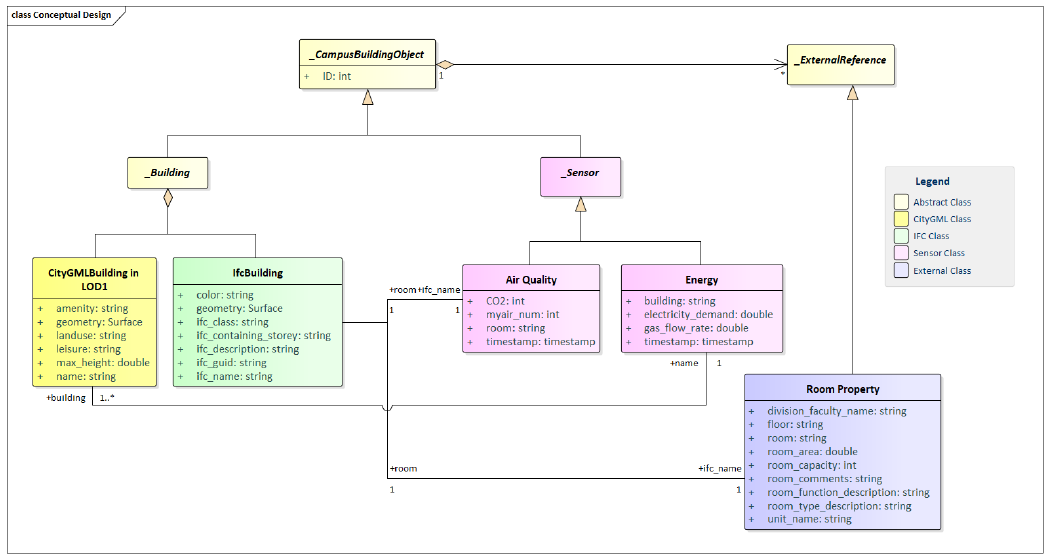
Figure 5. UML diagram for our conceptual design.